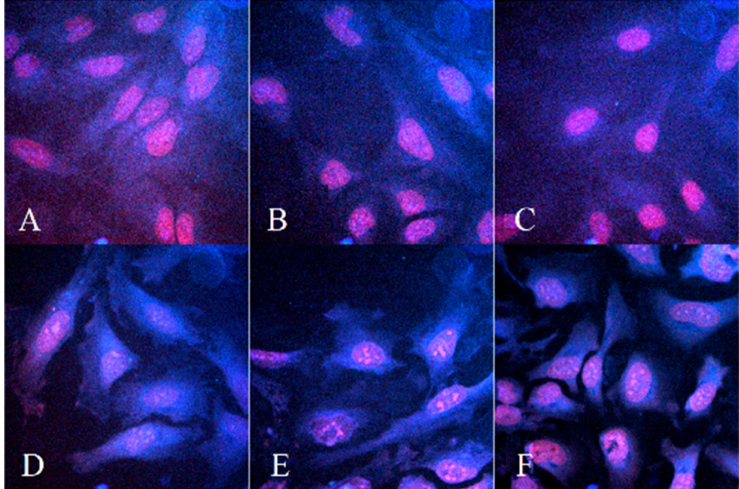
Figure 5. Confocal image of Hela cells after 60 min, 120 min and 24 h of TMPyP ( A – C ) and GO / TMPyP nanocarrier ( D – F ) at concentration of 25 µ M. Red (pink) areas depict TMPyP or GO / TMPyP inside nucleus. Note: ( A )—60 min TMPyP, ( B )—120 min TMPyP, ( C )—24 h TMPyP, ( D )—60 min GO / TMPyP, ( E )—120 min GO / TMPyP, ( F )—24 h GO / TMPyP. Magnification is 40 ×